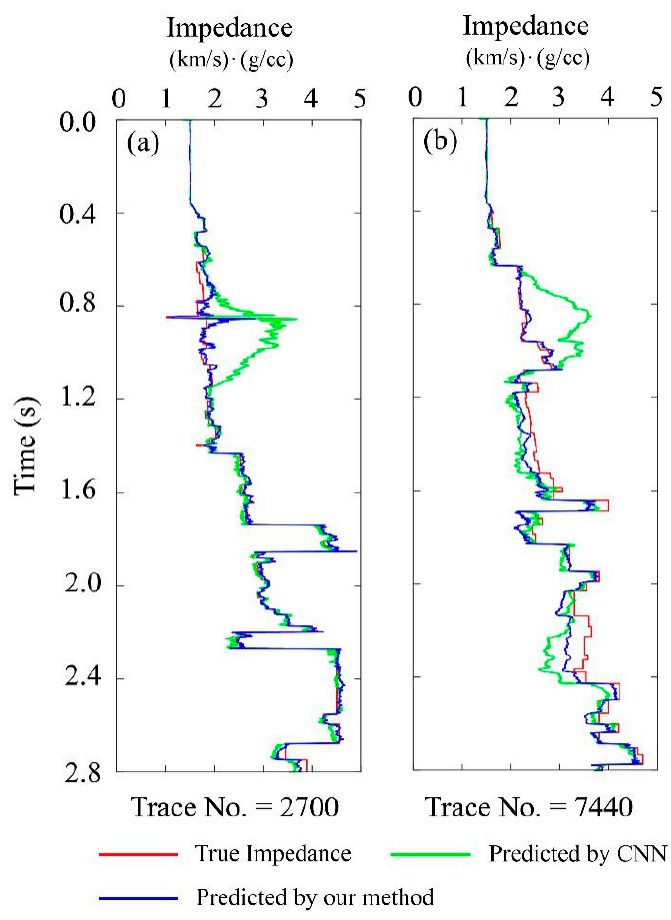
Figure 6. Impedance of the selected representative traces. ( a ) Trace number: 2700; ( b ) Trace number: 7440.